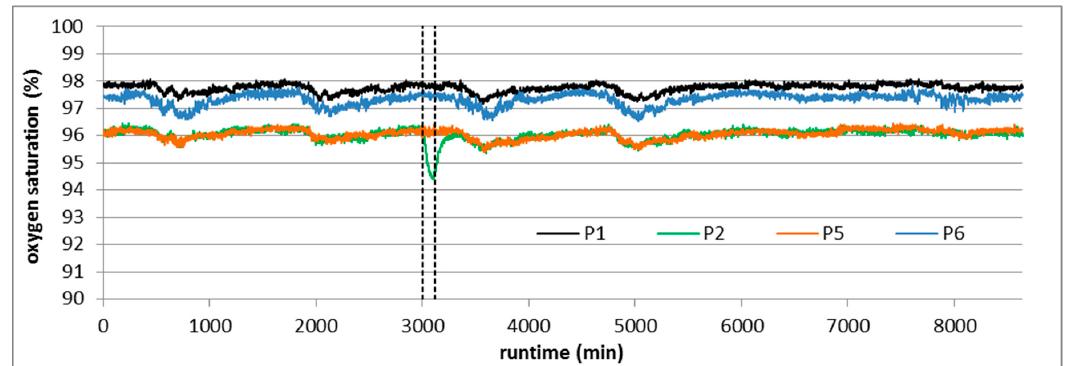
Figure 7 . Oxygen saturation in the 3D-Tank (observation points: P1, P2, P5, and P6) before, during and after the precipitation event of statistical recurrence interval of five years (WW-RE-Ref (sep.)), black dashed line indicates duration of precipitation event.